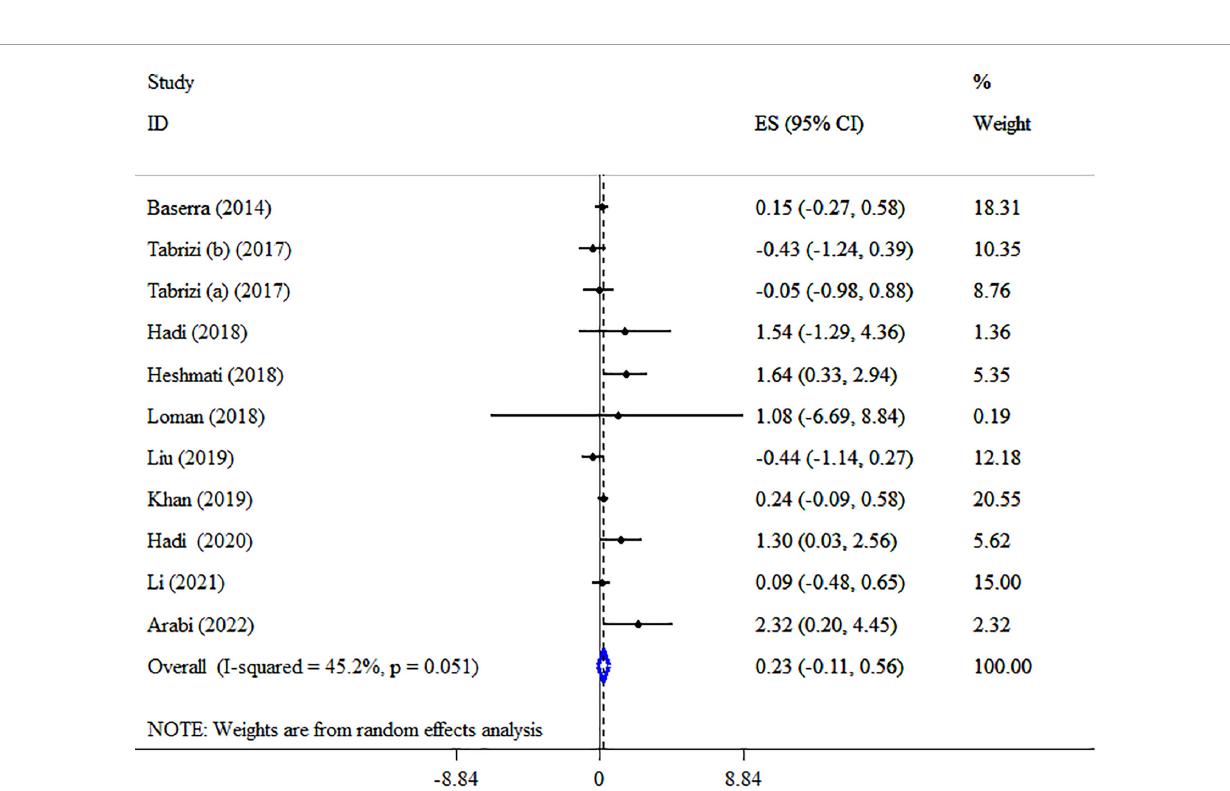
FIGURE8 Forest plot detailing mean difference and 95% confidence intervals (CIs), the impacts of synbiotic supplementation on HDL-C levels.